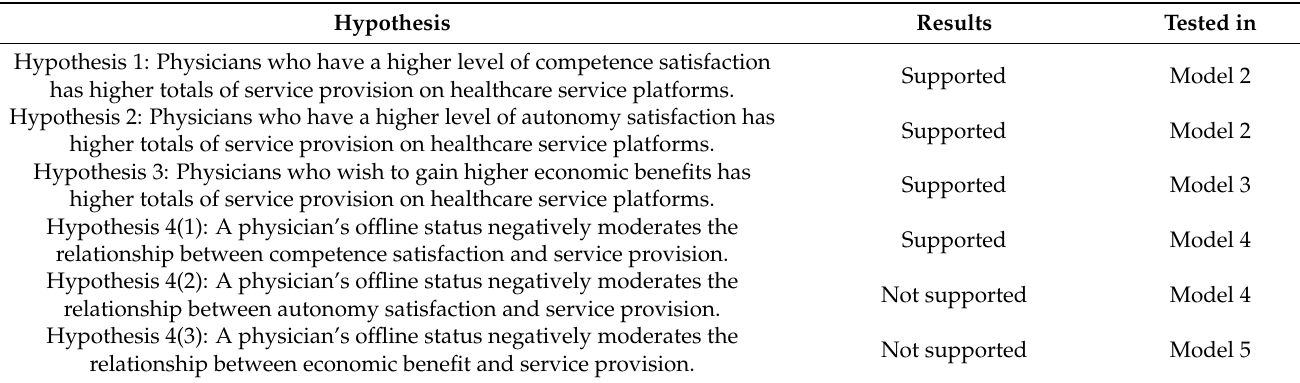
Table 4. Summary of